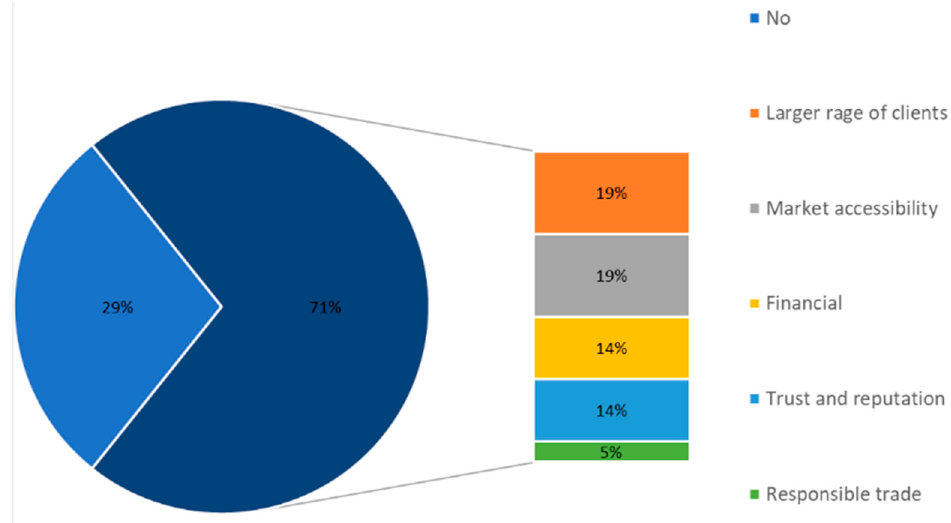
Figure 4. FSC certification advantages perceived by customers.